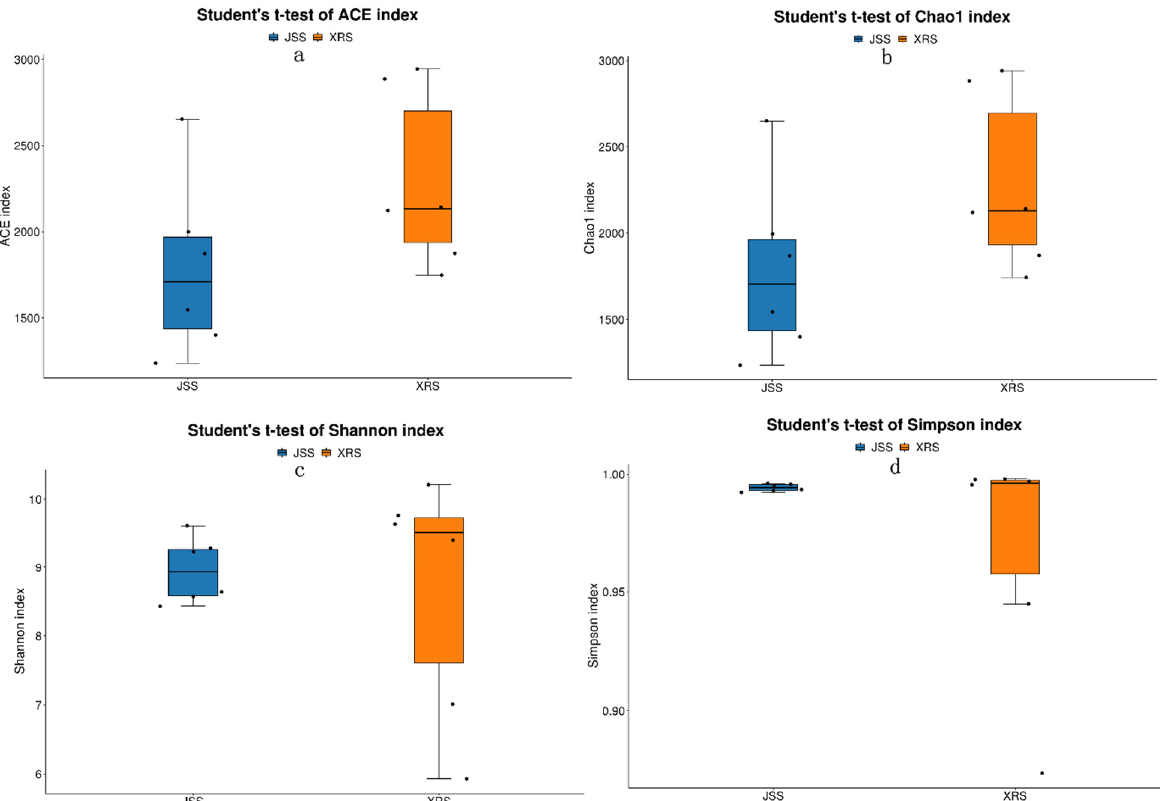
Figure 3. Alpha diversity Index of bacteria among different groups. ( a ) ACE; ( b ) Chao1; ( c ) Shannon; ( d ) Simpson. One dot represents significant difference ( p < 0.05) and two dots represent highly significant difference ( p < 0.01) between treatments. JSS: the bulk soil sample; XRS: soil of the P. sibiricum rhizosphere.